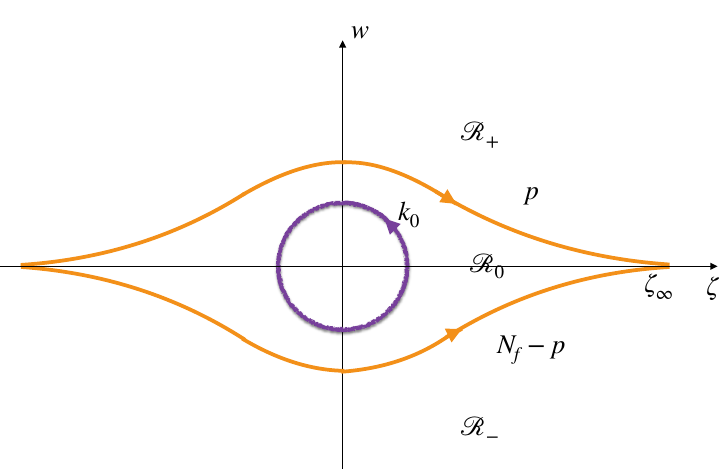
Figure 11 . The D-brane configuration including Chern-Simons (purple) and flavor (orange) branes in the { w, ζ } plane with massless boundary condition. p of N f flavor branes extend in the upper plane while the other N f − p flavor branes extend in the lower plane. The Chern-Simons is located at u = u KK to minimize its energy as discussed in section